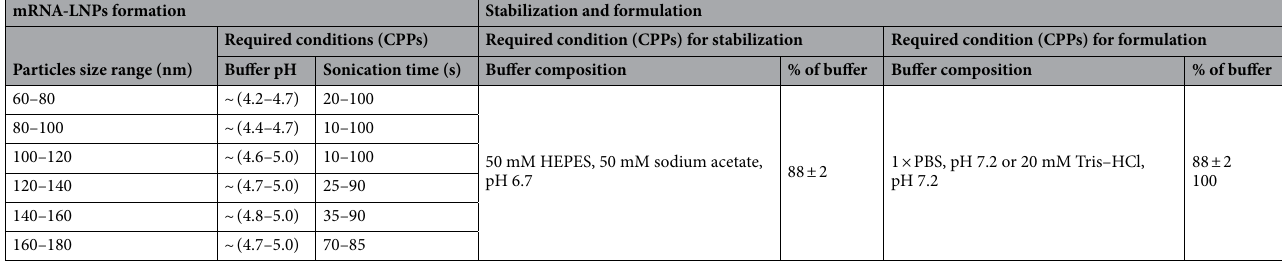
Table 1. Critical process parameters for LNP formation, stabilization and